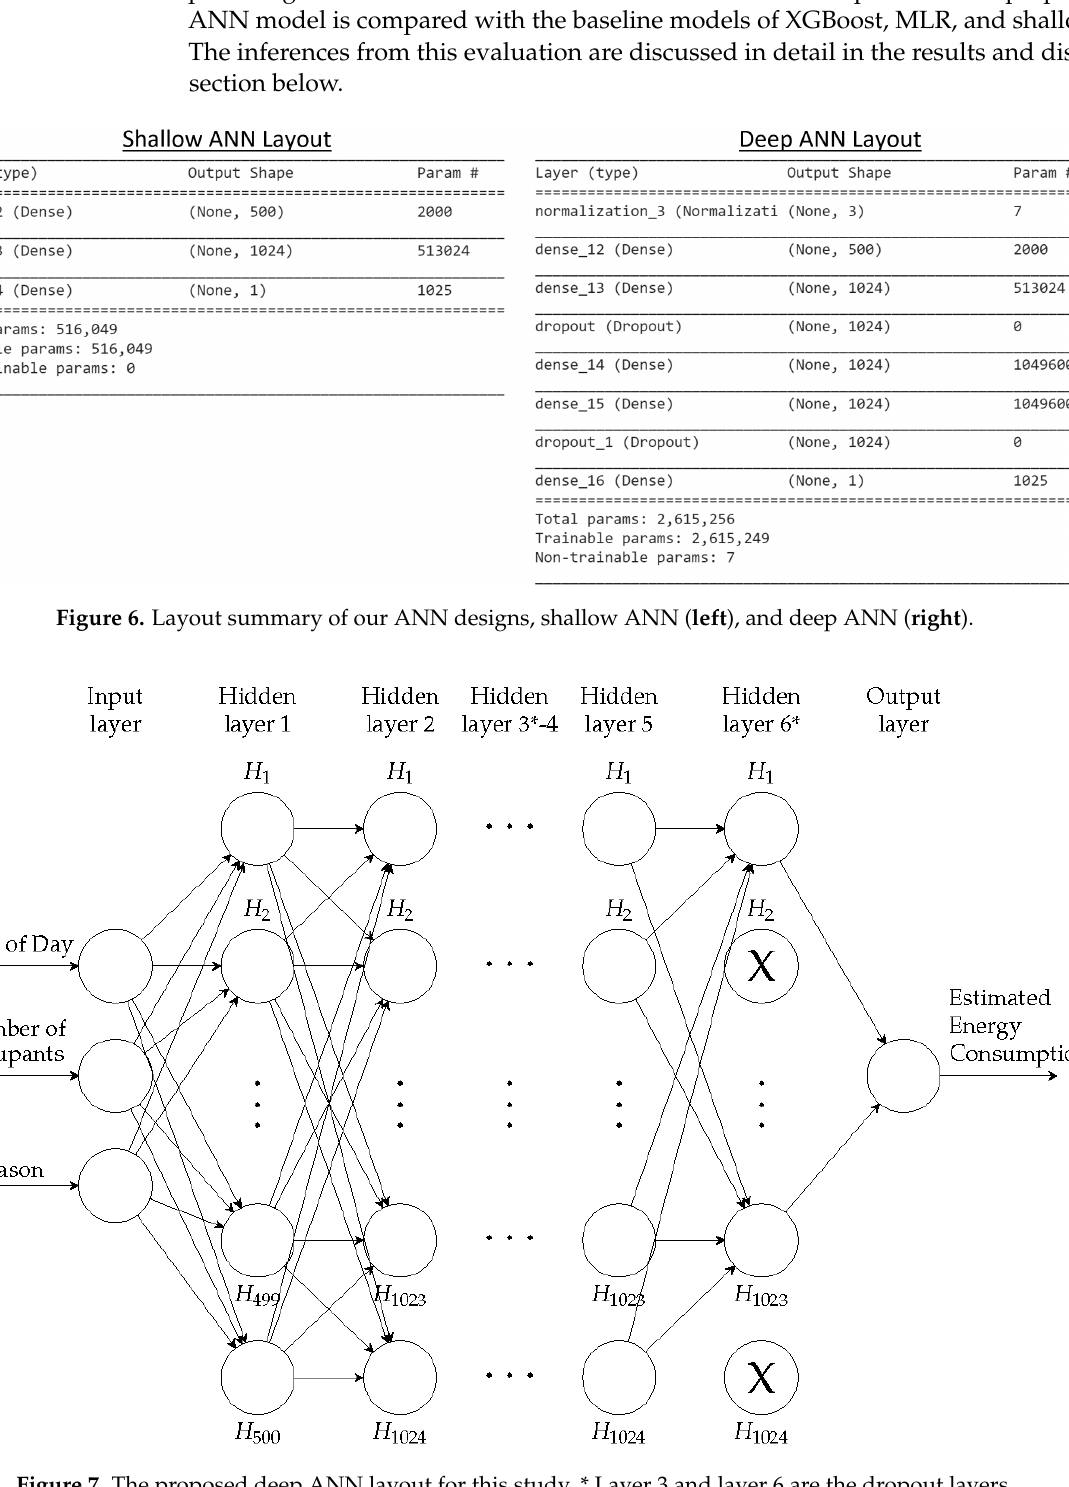
Figure 7. The proposed deep ANN layout for this study. * Layer 3 and layer 6 are the dropout